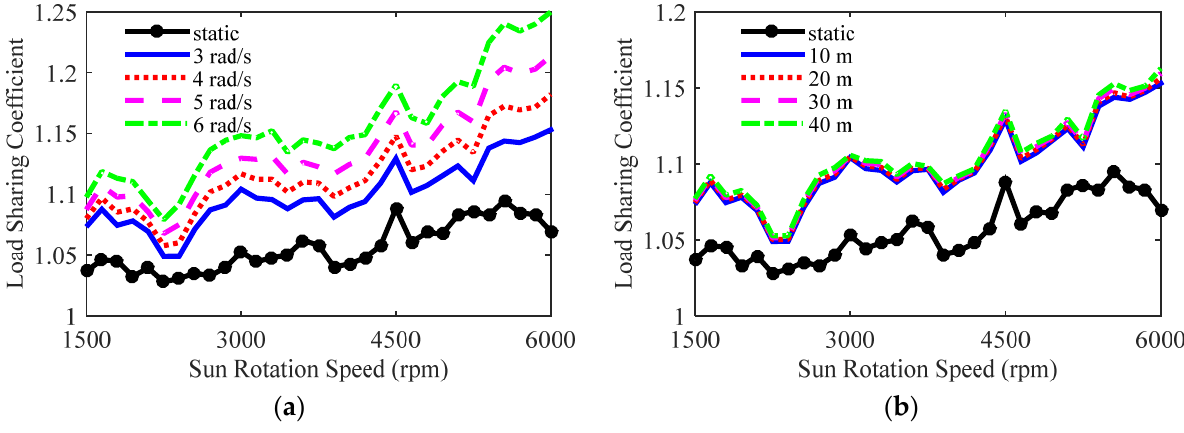
Figure 19. Influence of input speed on LSC under loop maneuver. ( a ) At different LAV; ( b ) At different LR.